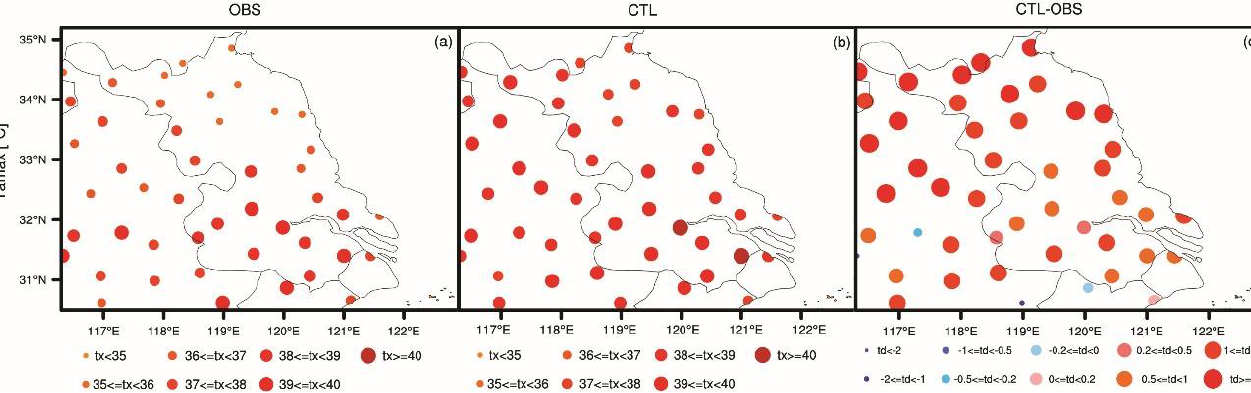
Table 2. Statistical values of observed and simulated 5-day mean Ta and Tamax in study region, °C.